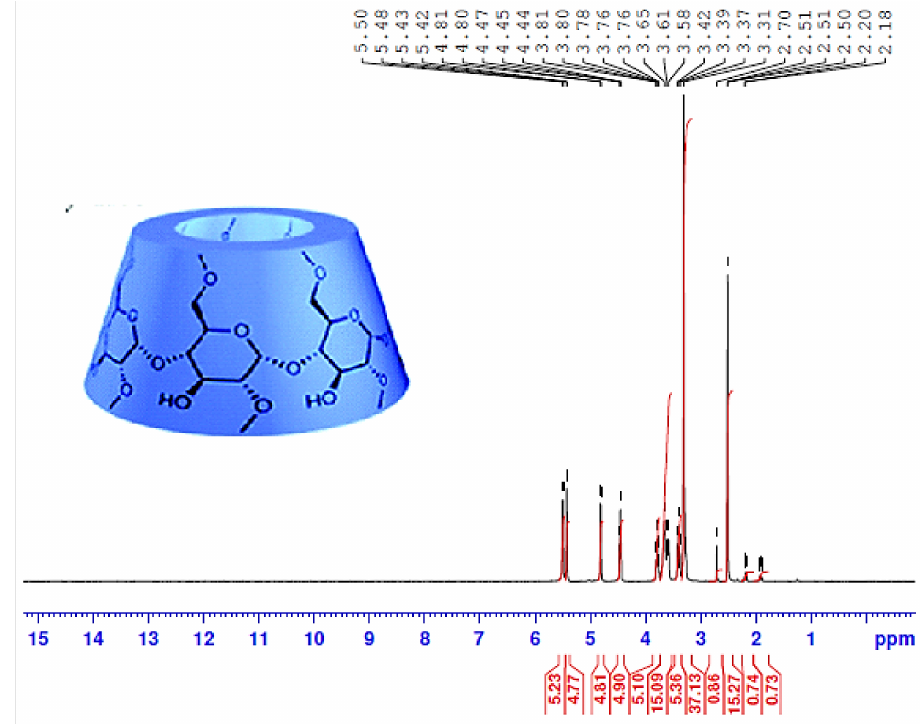
Figure 4. 1 H-NMR spectra for α -CD in DMSO-d 6 .